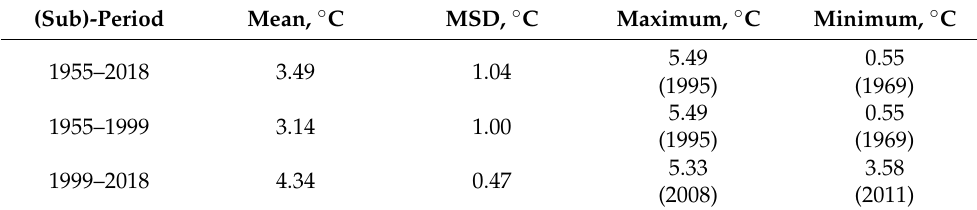
Table 1. Air temperature regime in the Volga Federal District during 1955–2018.